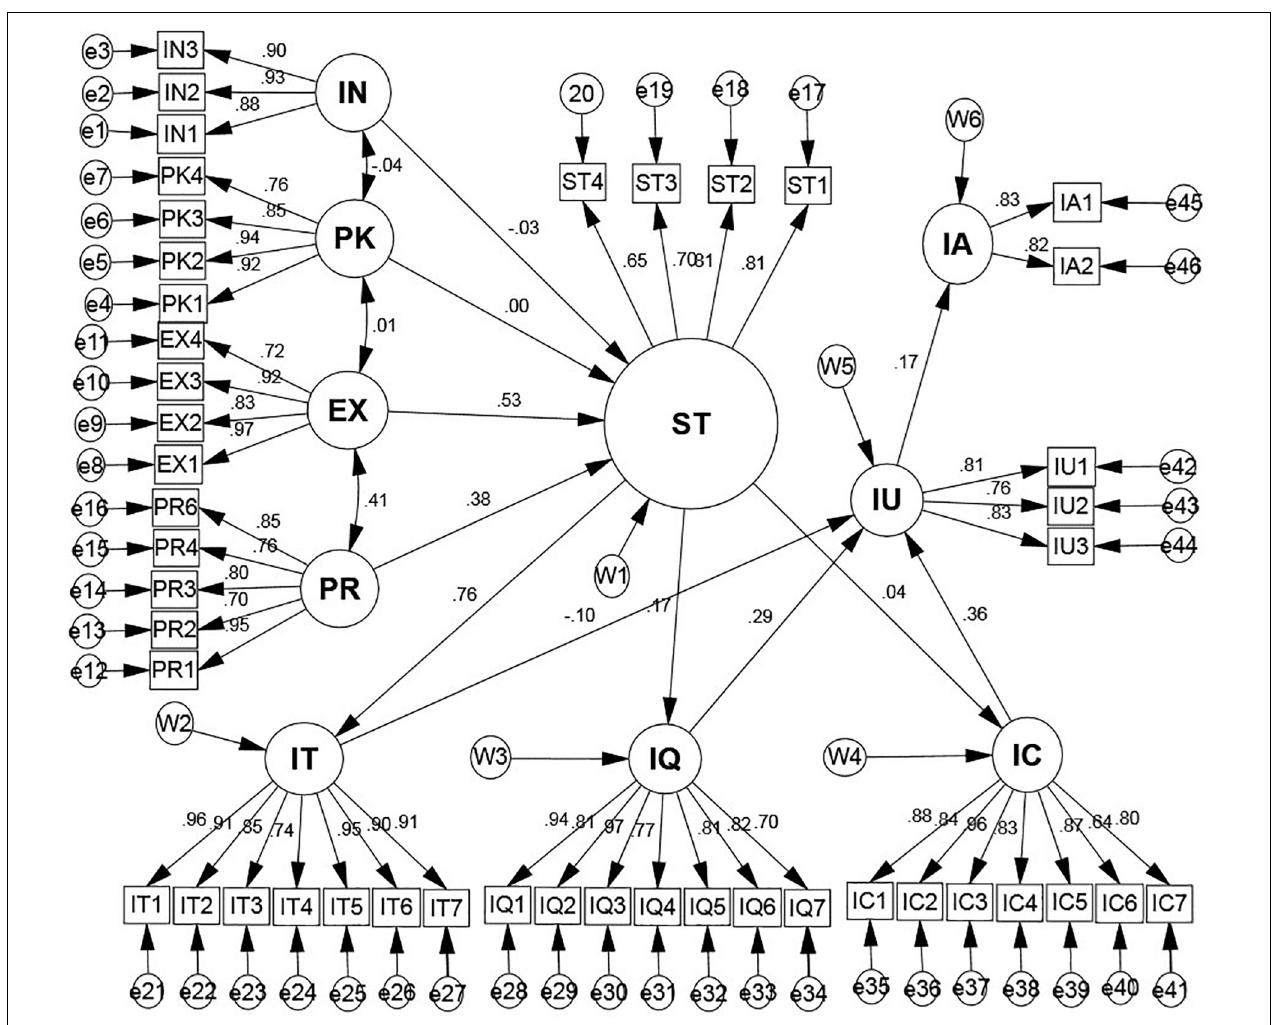
FIGURE 2 | The structural model: IN, information need; PK, prior knowledge; EX, experience; PR, perceived risk; ST, social tie; IT, involvement; IQ, information quality; IC, information credibility; IU, information usefulness; IA, information adoption.